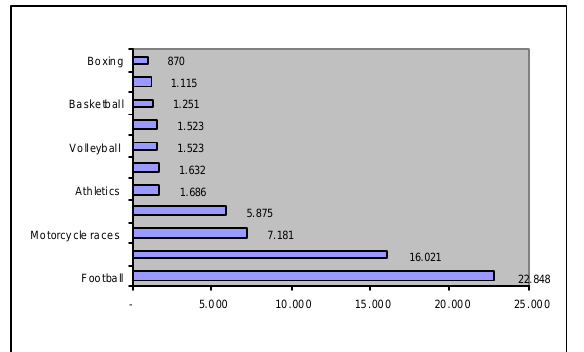
Figure 11: TV Viewers of Sport Events in Italy